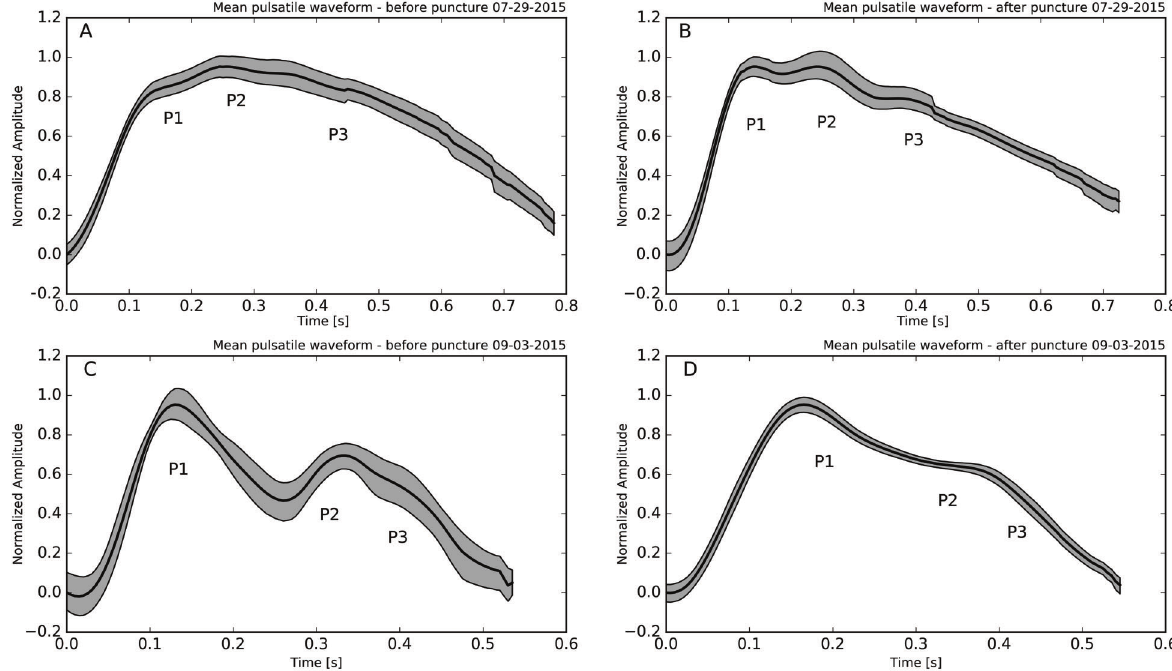
Figure 2. Normalized mean pulsatile waveform from non-invasive intracranial pressure (ICP-NI) measurement. A , Pulsatile waveform before lumbar puncture on D12 (P2 4 P1), showing the presence of neurological symptoms. B , Pulsatile waveform at D12 after lumbar puncture (P1 4 P2), showing improvement of neurological symptoms. Pulsatile waveform on D34 before ( C ) and after ( D ) lumbar puncture with P1 4 P2 in the fi nal recovery phase, with a normal clinical and neurological physical exam. The black line represents the average and the gray shadows represent 95% con fi dence intervals (nonparametric bootstrap, a =0.05, N=1000).